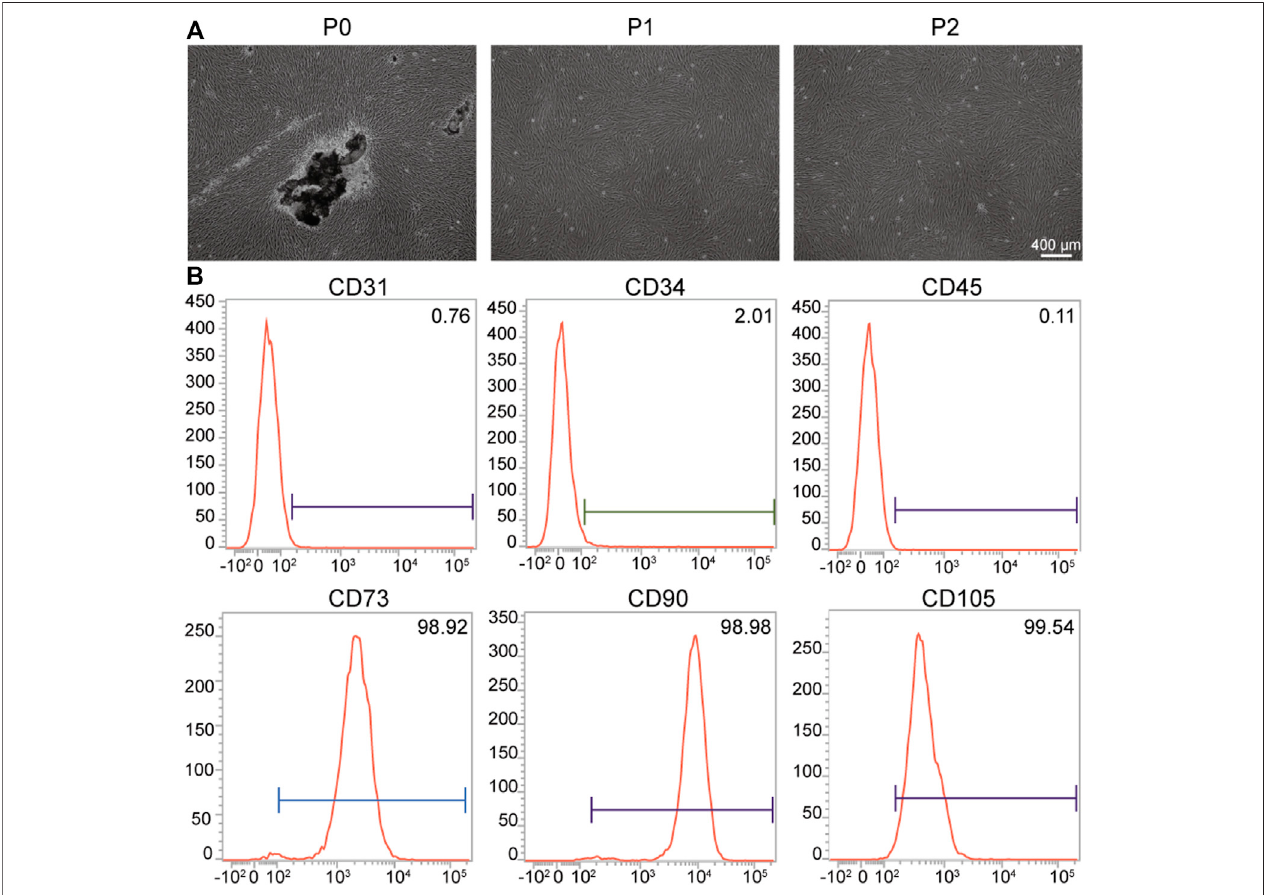
FIGURE 2 | Culture and identi fi cation of hPDLSCs. (A) Morphology of hPDLSCs; (B) Flow cytometry analysis of the indicated cell surface marker expression in hPDLSCs.